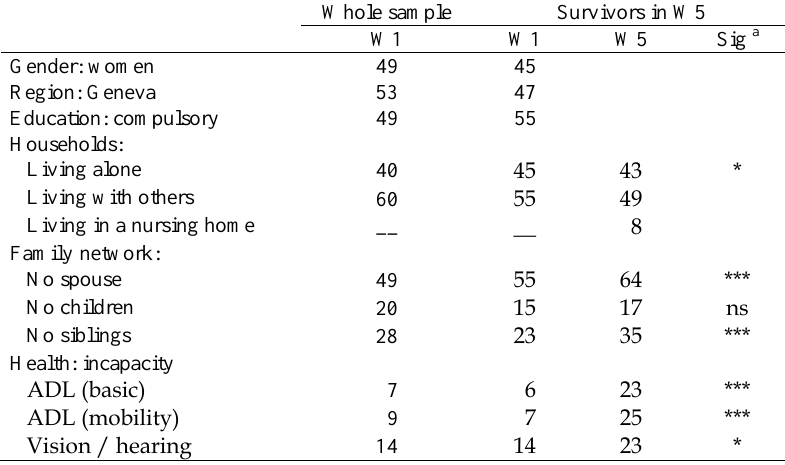
Table 1 . Characteristics (%) of cohort in W 1 (n = 295 ) and changes be- tween W 1 and W 5 (n = 157 ) Whole sample Survivors in W5